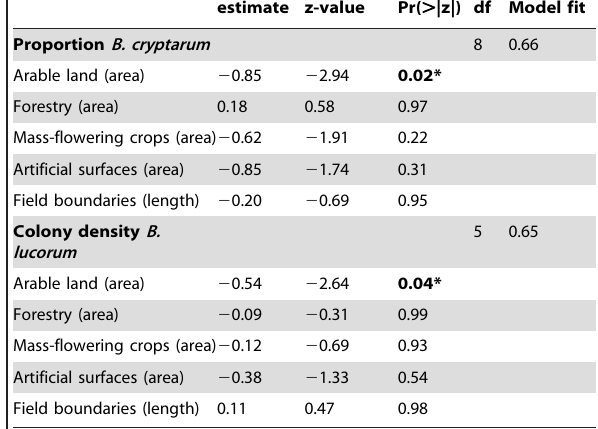
Table 3. Results of multiple comparisons of variables from generalized linear models investigating the effects of landscape composition measured within a 700 m radius on proportions and colony densities of each species.